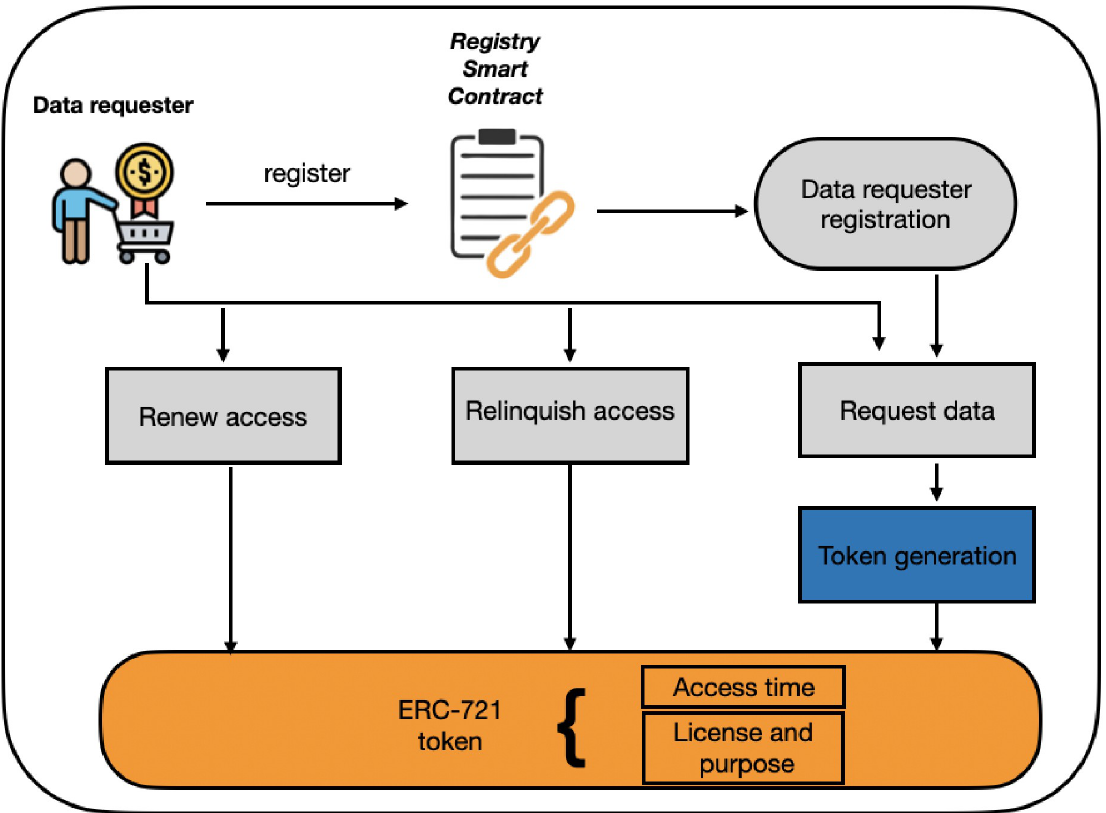
Fig 2. Access methods for a data requester in the access smart contract